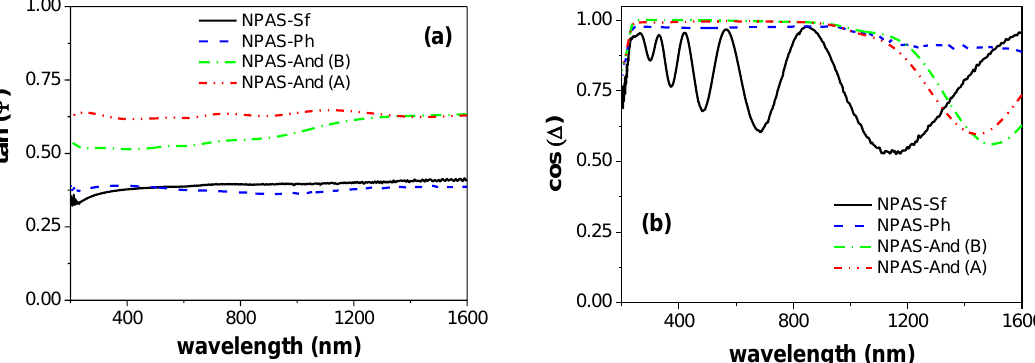
Figure 3. Wavelength dependence of ( a ) tan( Ψ ) and ( b ) cos( ∆ ) experimental values for samples: NPAS-Sf (black dense line), NPAS-Ph (blue dashed line), NPAS-And surface A (green dashed-dotted line), and NPAS-And surface B (red dashed-dotted-dotted line).